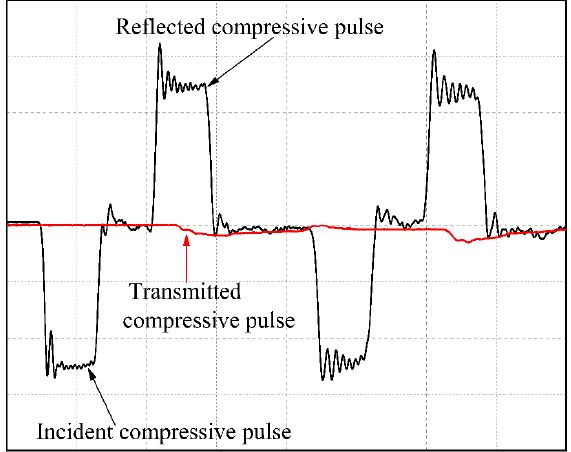
Figure 7. Typical dynamic compressive responses from strain gages.